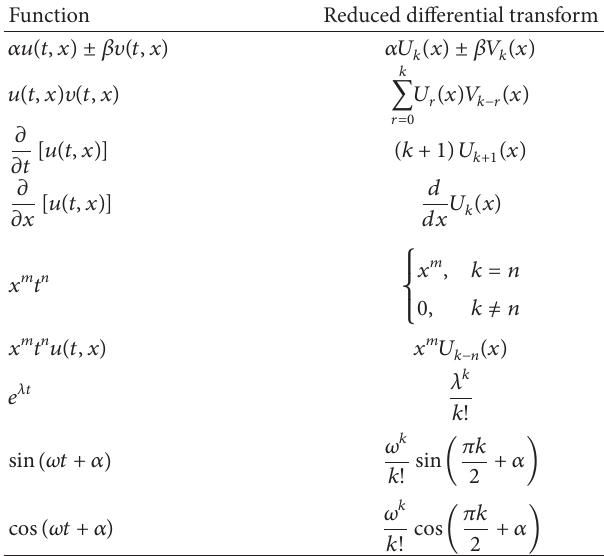
Table 1: Main operations of